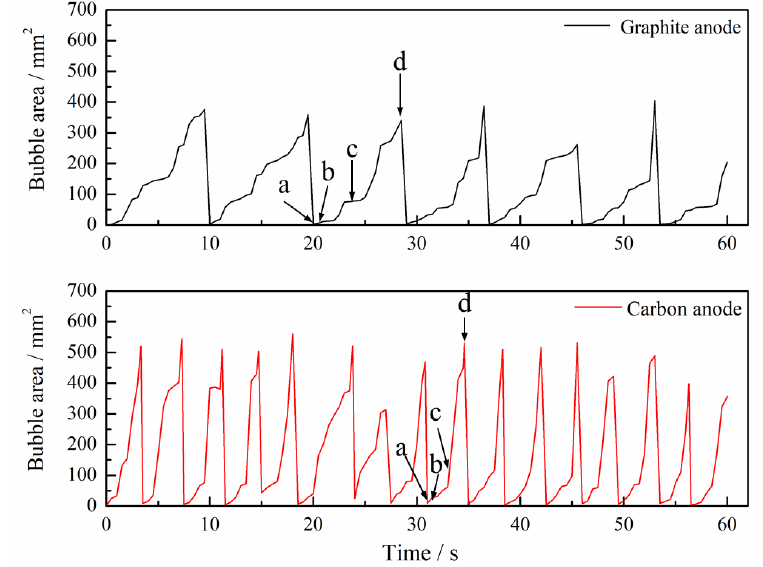
Figure 7. Fluctuation in the largest bubble area on the carbon and graphite anodes over time. a-stage 1; b-stage 2; c-stage 3; d-stage 4.